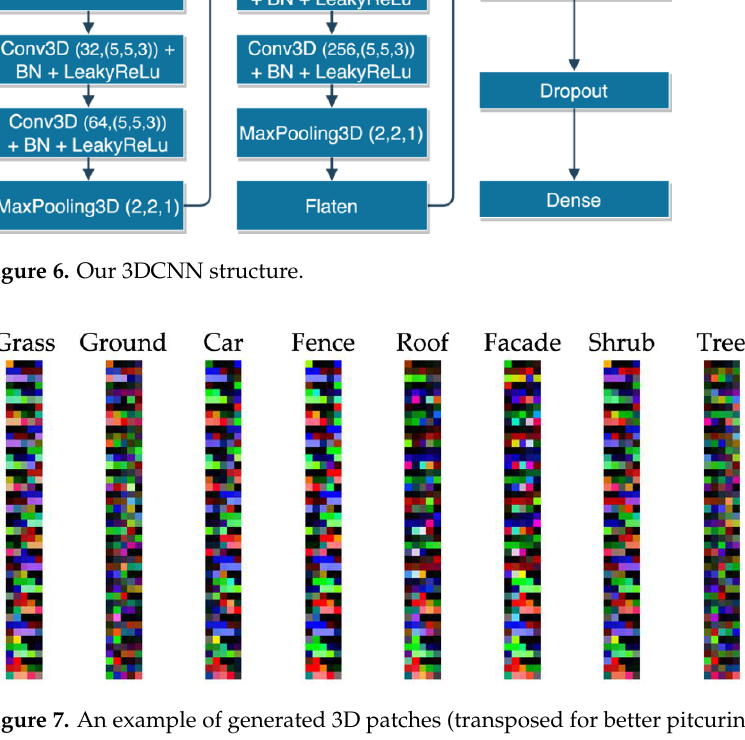
Figure 5. An example of 2D patch visualization (transposed for better picturing).